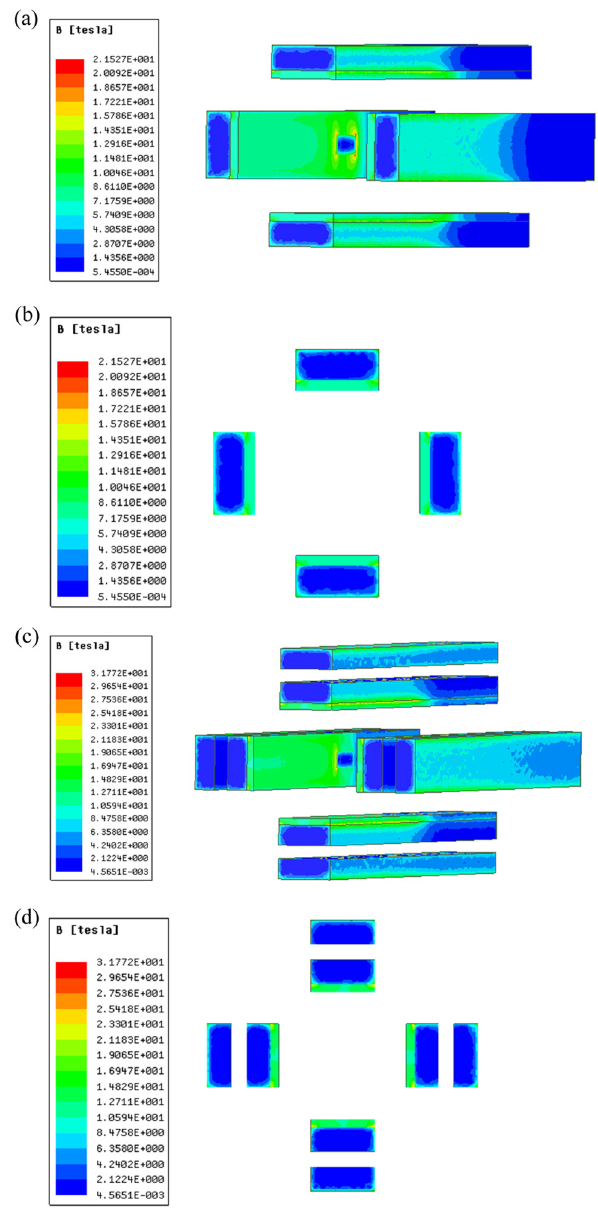
Figure 12: Magnetic fi eld distribution of the rail. ( a ) Magnetic fi eld distribution of CFREL, ( b ) magnetic fi eld in contact surface of CFREL, ( c ) magnetic fi eld distribution of ECFREL, and ( d ) magnetic fi eld in contact surface of ECFREL.